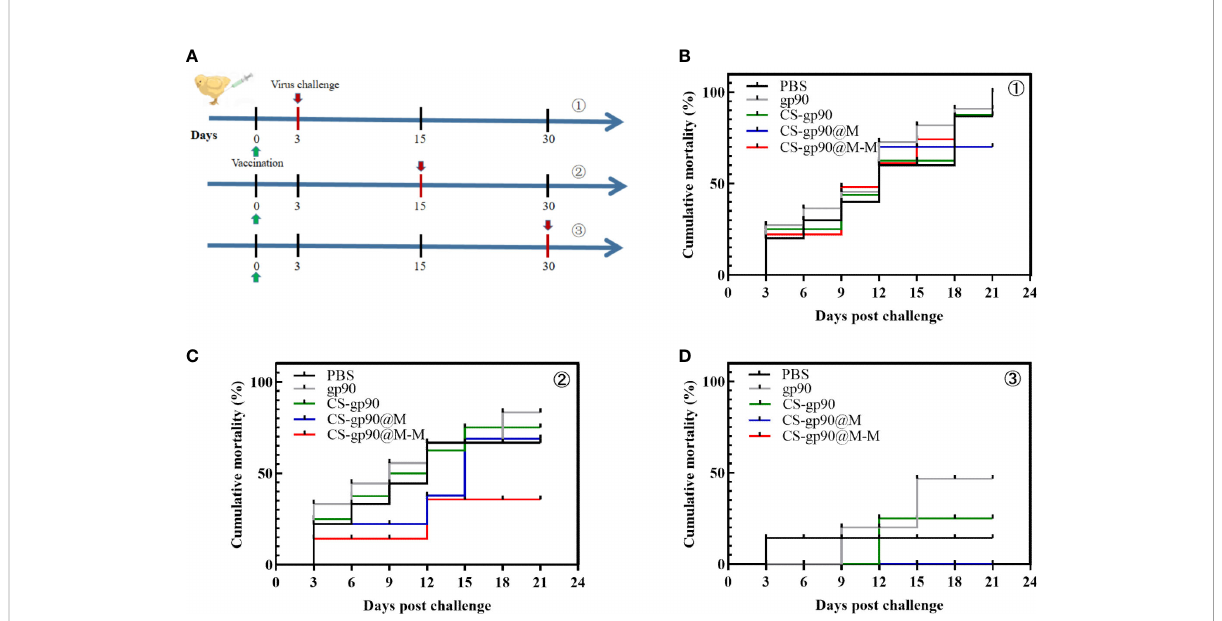
FIGURE 7 Protective effect of CS-gp90@M-M NPs in chicks infected with REV. (A) Schematic diagram demonstrating the REV challenge. Vaccinated chicks were challenged with REV on the 3rd (B) , 15th (C) , and 30th (D) days after vaccination.